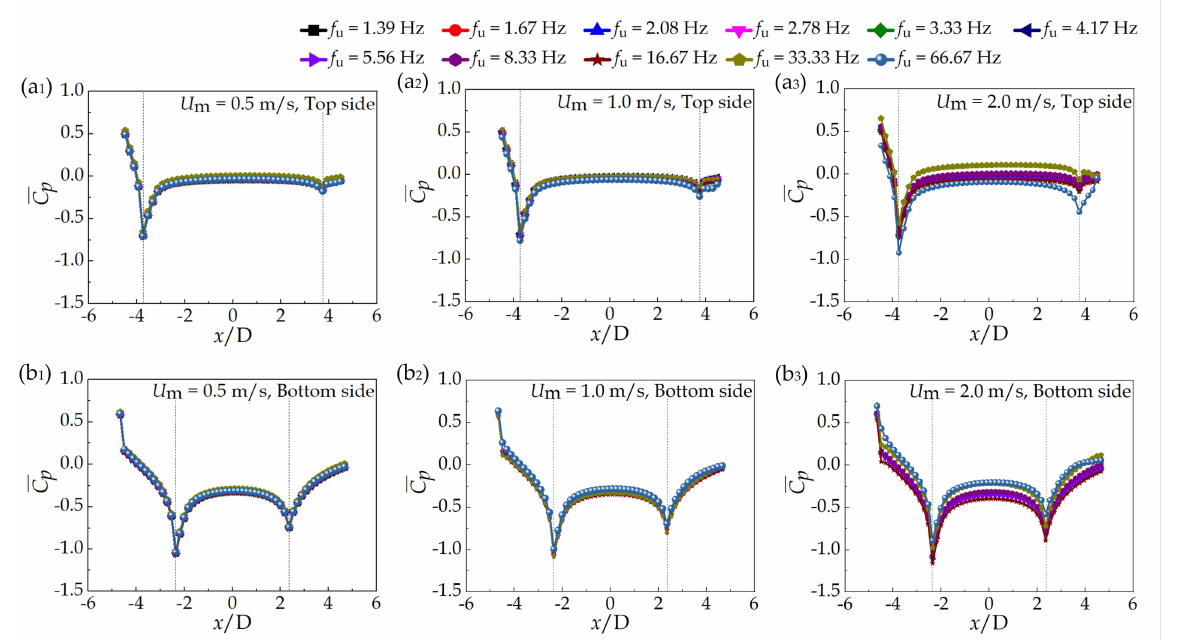
Figure 5. Mean pressure coefficients in streamwise sinusoidal oscillating flows: ( a 1 ) U m = 0.5 m/s, top side; ( a 2 ) U m = 1.0 m/s, top side; ( a 3 ) U m = 2.0 m/s, top side; ( b 1 ) U m = 0.5 m/s, bottom side;